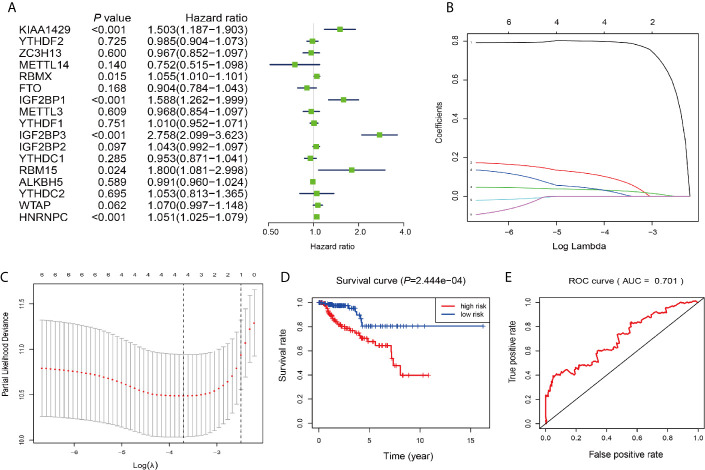
Construction of the risk signature according to the m6A RNA methylation regulators. (A–C) The process of building the signature containing two m6A RNA methylation regulators. Hazard ratios (HR, the center of the box) and 95% confidence intervals (CI, horizontal line) were calculated with Cox’s regression models. (D) Kaplan-Meier survival curves for OS in the CCRT-along groups of low and high risk. (E) ROC curve and AUC value.